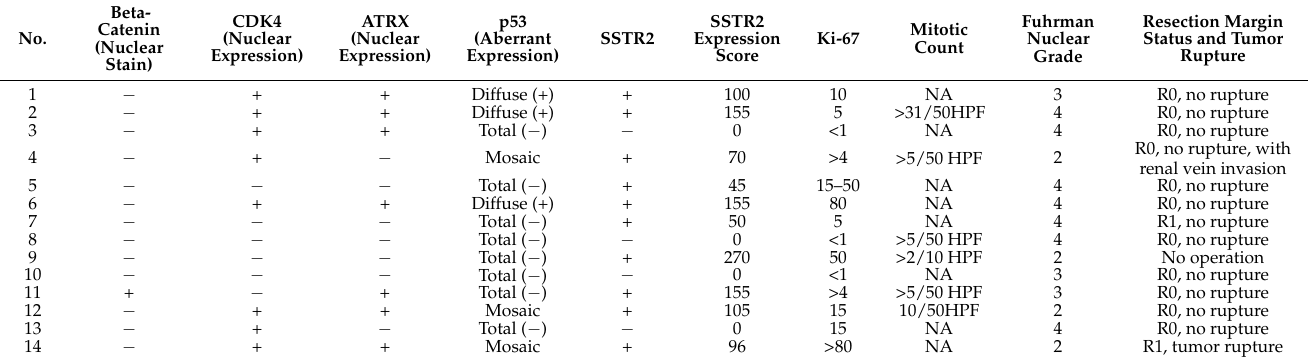
Table 2. Results of immunohistochemical staining and pathological characteristics for 14 patients with